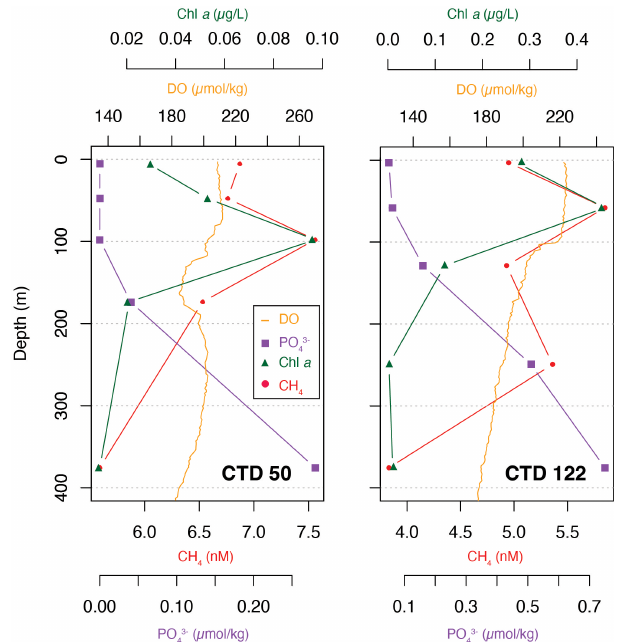
Figure 6. Selected data from CTD 50 (69.5 ◦ W, 24.9 ◦ N) and CTD 122 (20.8 ◦ W, 25.45 ◦ N) for CH 4 (red circles), Chl a (green trian- gles), phosphate (purple squares) and dissolved oxygen (orange).